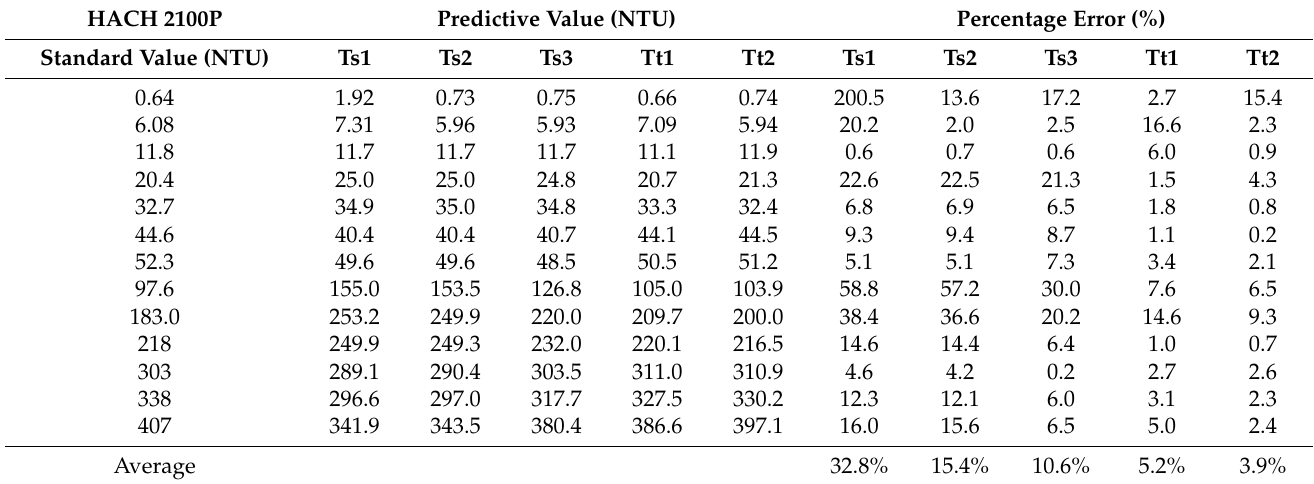
Table 5. Estimate results for concentrations of standard turbidity solutions (VIS).